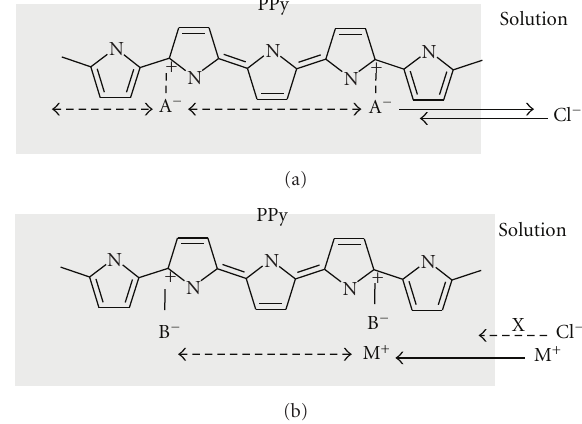
Figure 6: Ionic perm-selectivity of PPy film. (a) PPy film with anionic perm-selectivity, in which small-sized anions are doped in PPy and (b) PPy film with cationic perm-selectivity, in which large- sized anions are doped in PPy